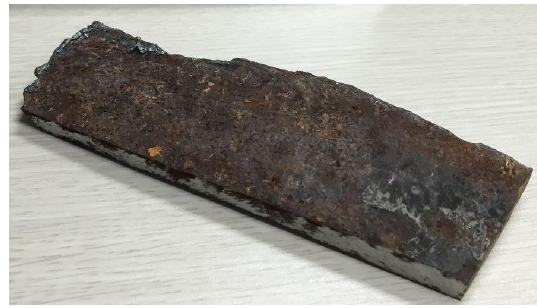
Figure 6: Destroyed material: medium-carbon steel 1030.